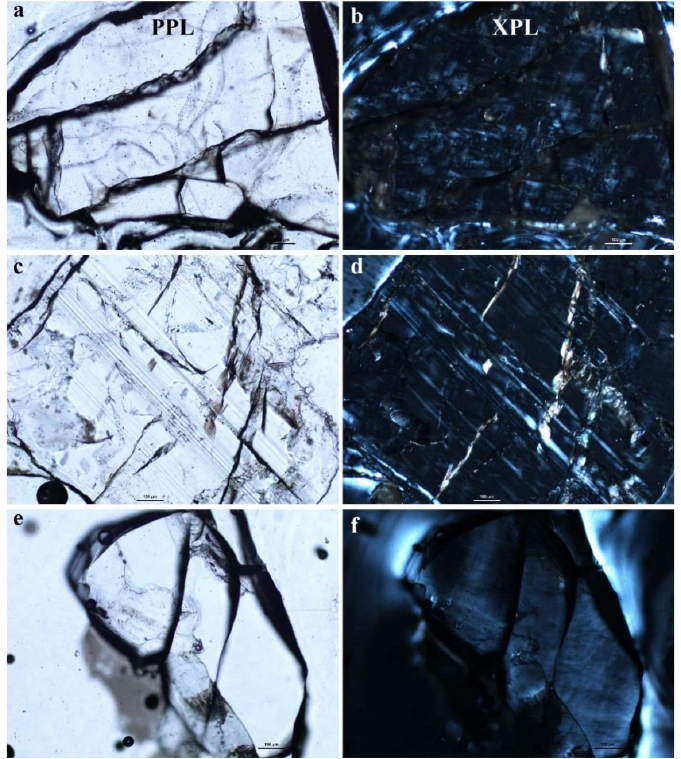
Figure 3. Thin-section images for birefringent grossular samples from Mexico: ( a , b ) raspberry-red sample-3 from Coahuila, ( c , d ) pink sample-4 from Chihuahua-p, and ( e , f ) creamy-white sample-5 from Chihuahua-w; ( a , c , e ) are in plane-polarized light (PPL), whereas ( b , d , f ) are in cross-polarized light (XPL). Birefringent, lamellar, mottled, or tweed-like features are contained in these sam- ples. The scale bars in each image represent 100 µ m. The lamellar features in ( c , d ) may represent different